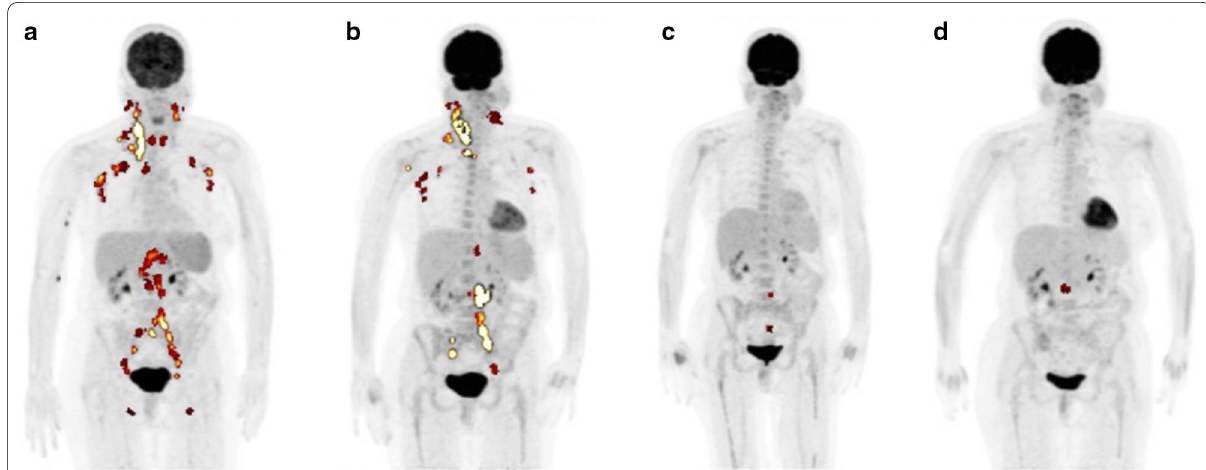
Fig. 4 FDG‑PET images of a multicentric Castleman disease (MCD) subject over 8 months. a and b demonstrate cervical, axillary, and pelvic lesions, while c and d show decrease in FDG‑uptake in accordance to treatment. Total lesion glycolysis (TLG) was calculated to be 934.7, 1001.7, 17.5, and 16.4 for a–d respectively. TLG was calculated by multiplying the metabolic volume with FDG uptake segmented by fixed threshold methods at 41% of maximum SUV in the volume of interest (VOI) [75] by the mean standardized uptake value (SUVmean) and them summing all the intensity‑volume product values from all lesions